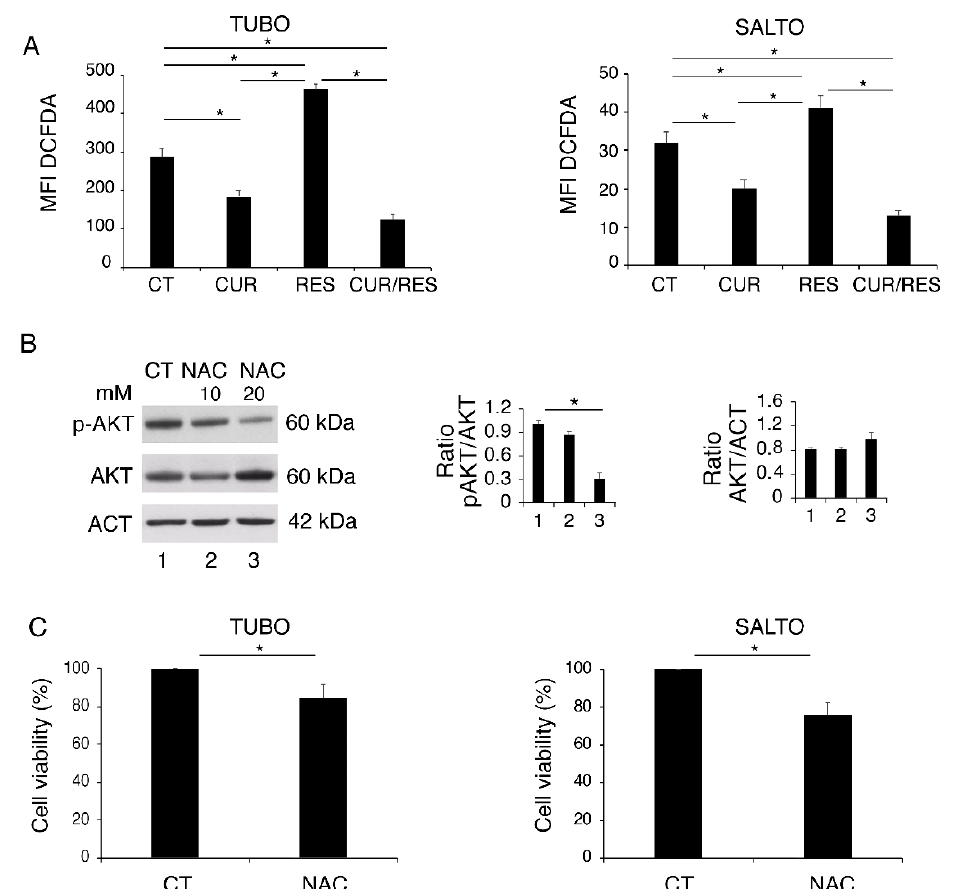
Figure 4. ROS modulation in curcumin-, resveratrol- and curcumin/resveratrol-treated cells. ( A ) Intracellular ROS levels after 48 h of curcumin, resveratrol and curcumin/resveratrol treatment, as evaluated by FACS analysis after DCFDA staining. Histograms represent the mean plus standard deviation of three independent experiments. ( B ) Dose-dependent effect of NAC (10 and 20 mM) on AKT phosphorylation in TUBO cells treated for 48 h with curcumin, resveratrol and curcumin/resveratrol. One representative experiment is shown. Actin was used as a loading control. Histograms represent the mean plus standard deviation of densitometric analysis of three independent experiments. ( C ) Cell survival as evaluated in TUBO cells treated by NAC (20 mM) for 48 h. Histograms represent the mean plus standard deviation of three independent experiments. * p value <